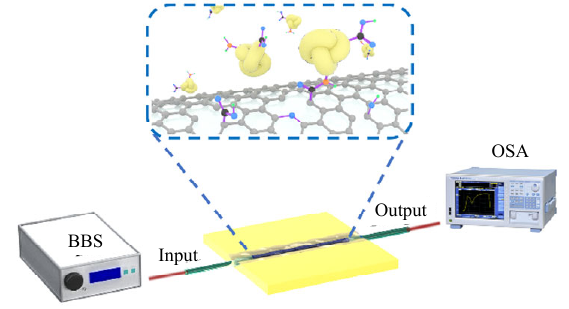
Fig. 3 Measurement system for testing the BSA by using the